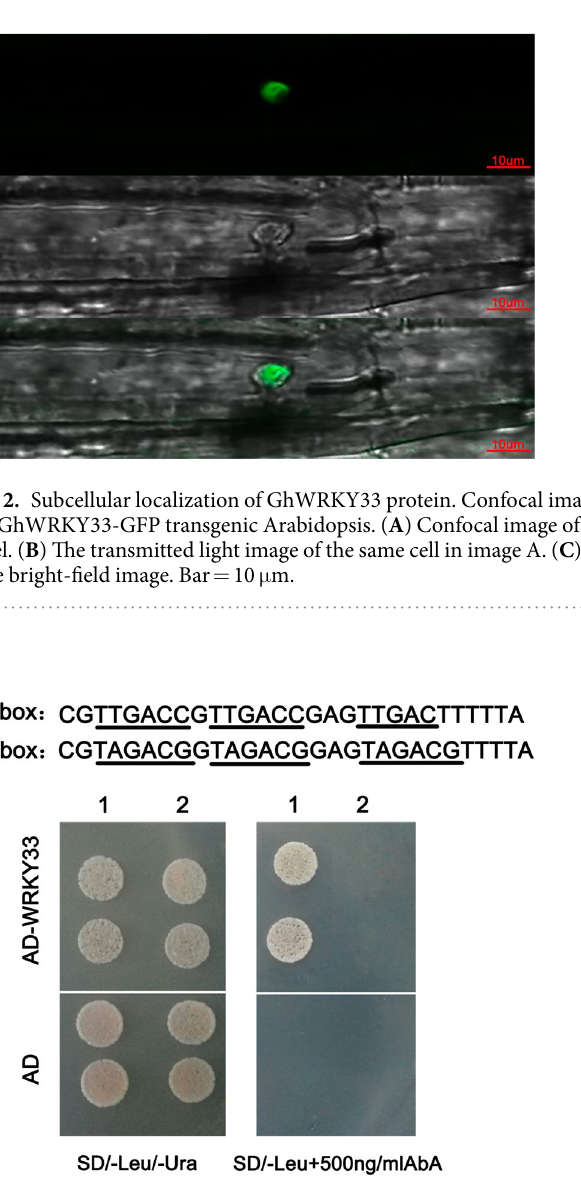
plants appeared to be yellowing and more withered than wild type controls which were still green. After re-watered, less than 20% of transgenic plants were survived, but wild type had more than 80% survival rate (Fig. 6B). Meanwhile, leaves from GhWRKY33 transgenic lines and wild type were detached from plants and weighed an hourly within 12 hours. We assumed weight loss is due to water loss from the leaves. In this experi- ment, the rate of water loss from leaves of GhWRKY33 overexpressing Arabidopsis was obviously higher relative to the wild type controls (Fig. 6C). When plants confront drought stress, the stomata serves as a vital gateway to limit water loss 32 . Therefore, stomatal conditions of GhWRKY33 transgenic lines and wild type were observed by microscopy with or with- out drought treatment. Under natural growth conditions, the GhWRKY33 transgenic Arabidopsis showed no significant difference in the ratio of stomatal length to width, compared with wild type controls. When exposed to drought, in contrast, the stomata of GhWRKY33 transgenic lines opened wider than those of wild type (Fig. 6D,E), indicating that GhWRKY33 overexpressing transgenic lines present higher water loss rate, mainly owing to the impaired stomatal closure. It has been suggested that environment stressors (including drought stress) may influence chlorophyll and proline contents in plants. Thus, we further determined the chlorophyll and proline contents in GhWRKY33 (2019) 9:724 | DOI:10.1038/s41598-018-37035-2